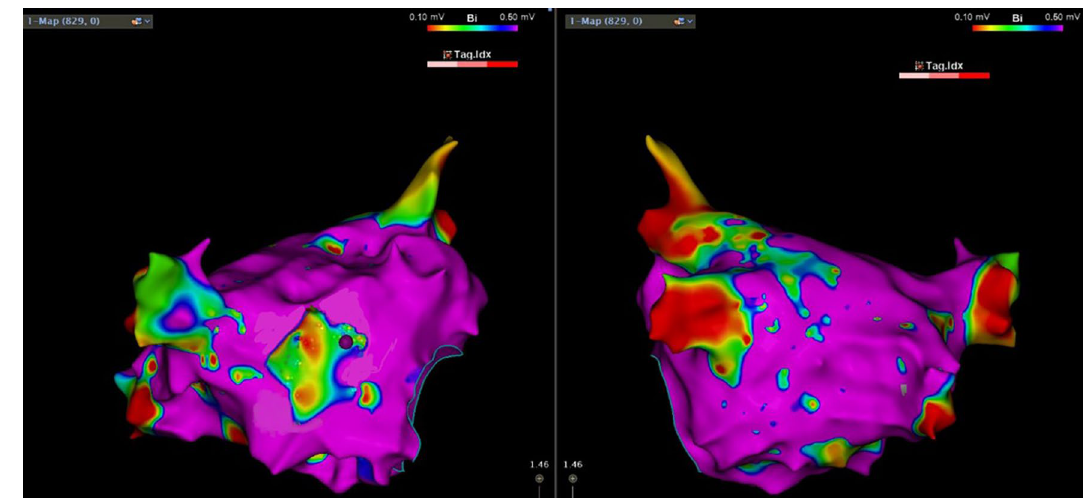
Figure 4. Left atrial (LA) electroanatomical maps created during sinus rhythm, and the location of the anterior wall low voltage zone (LVZ) of the left atrium. Posterior-anterior view (Left); anterior–posterior view (Right).